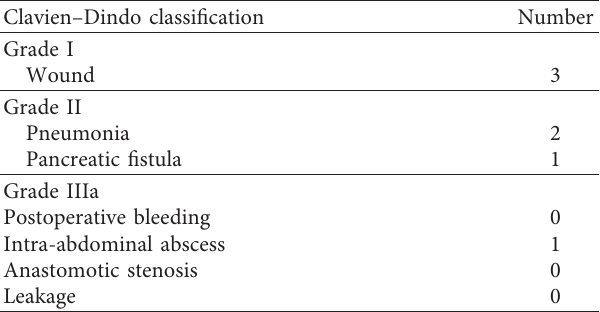
Table 4: Postoperative morbidity.